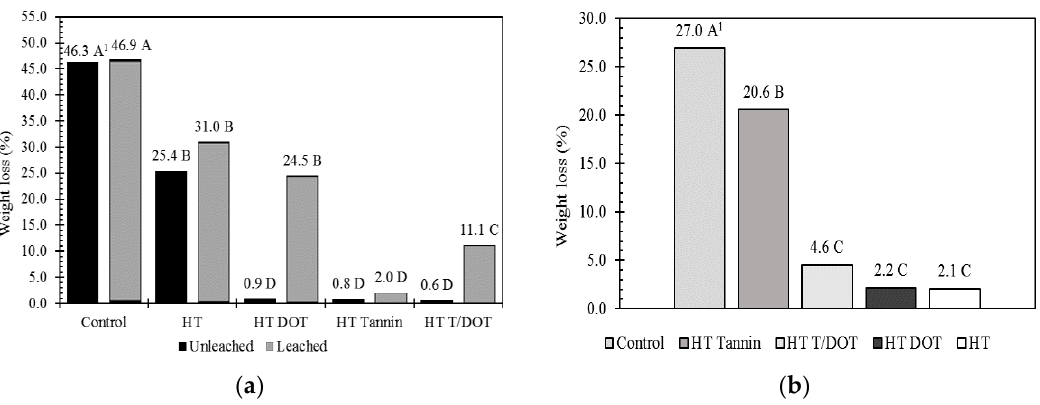
Figure 4. Weight loss caused by Gloeophyllum trabeum ( a ) and Trametes versicolor ( b ) on SYP and YP, respectively. 1 Means with the same letter were not statistically significant different at α = 0.05.